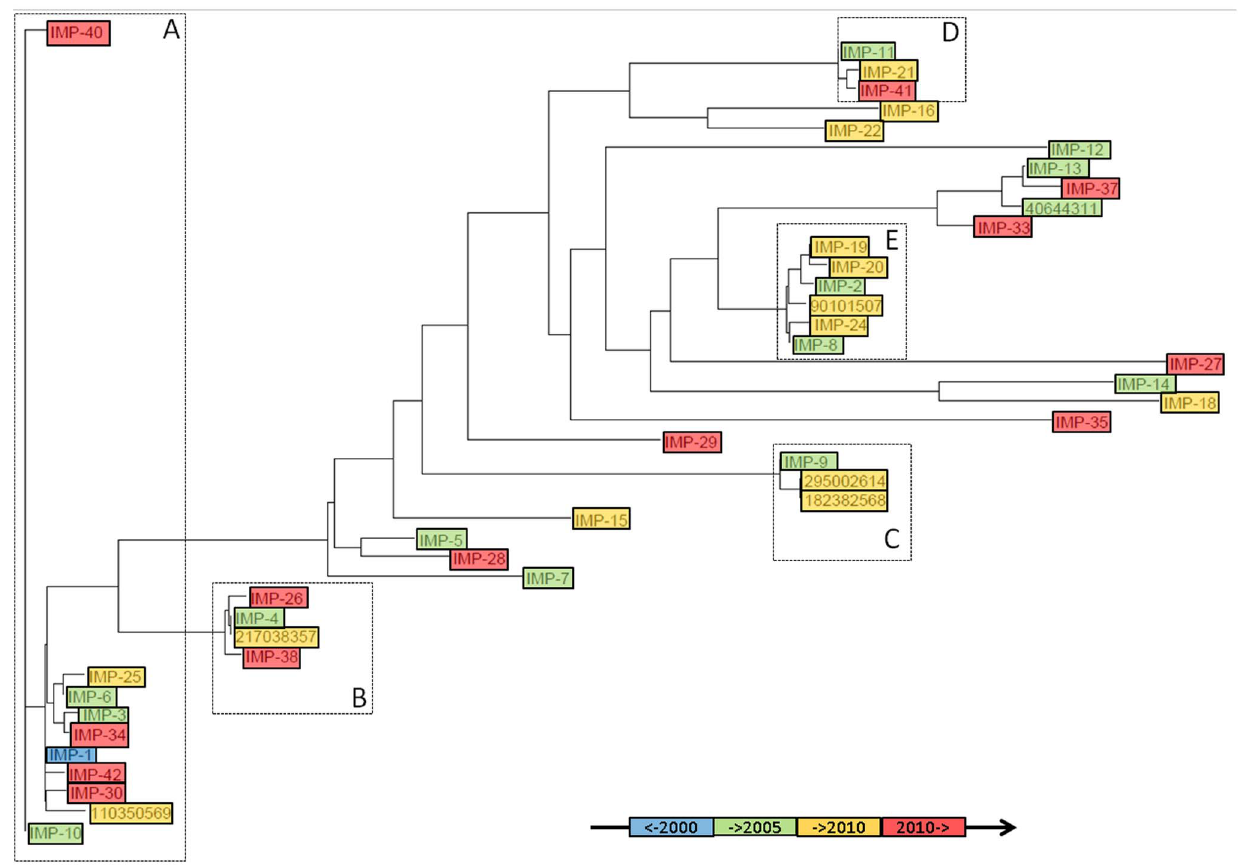
Figure 1. Phylogenetic tree of the IMP family of MBLs, colored by time of discovery (blue: before 2000, green: 2000-2005, yellow: 2005–2010, red: after 2010).